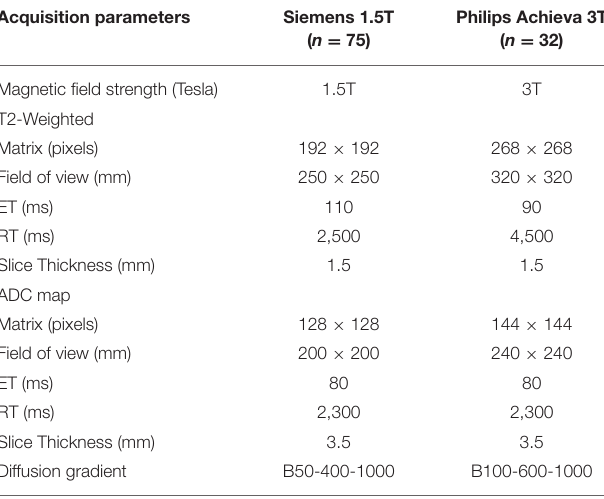
TABLE 1 | Summary of MRI scan acquisition parameters. Acquisition